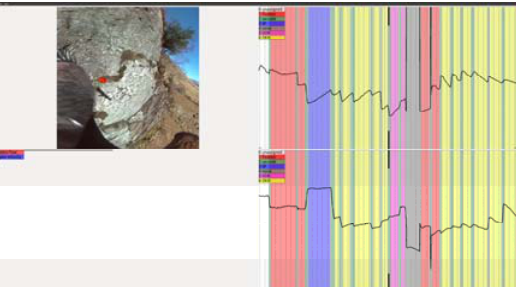
Figure 1. Screenshot of the hand‐labelling tool with field of view presentation enabled and fully annotated eye